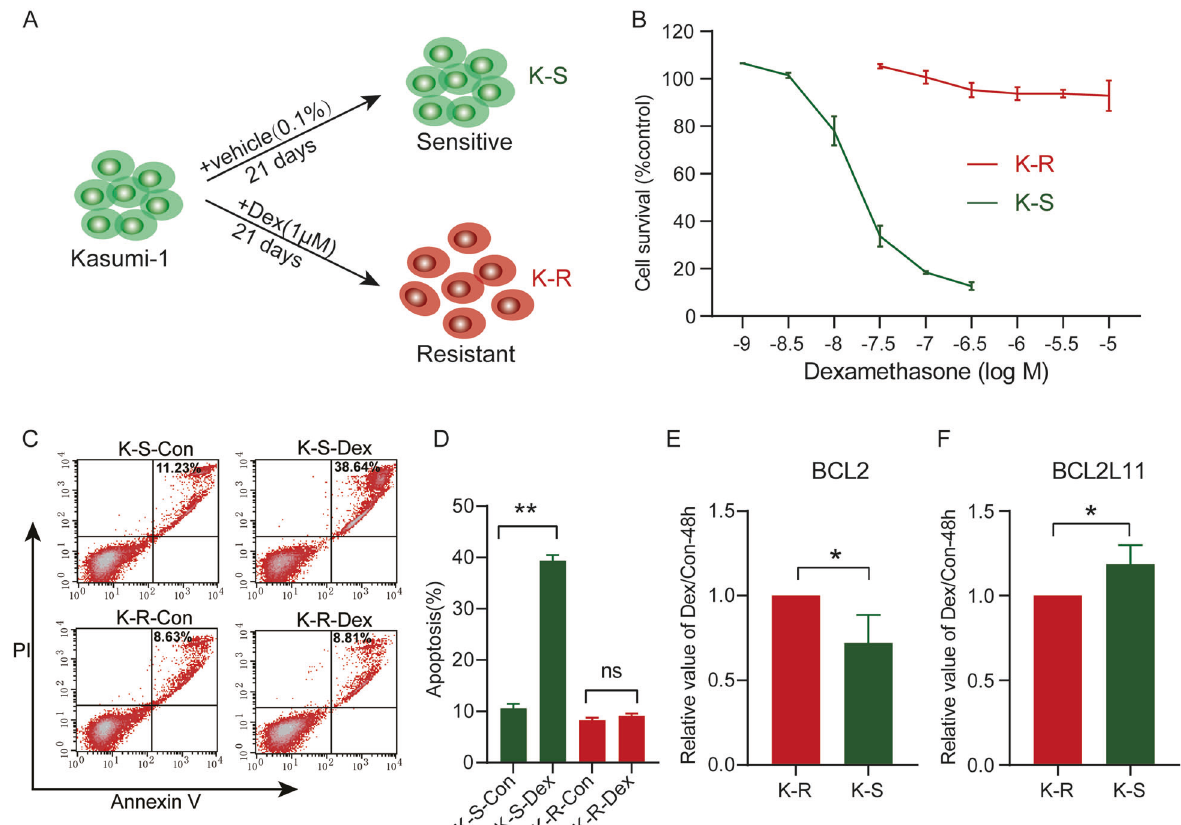
Fig. 1 Establishment and characterization of GC-resistant Kasumi-1 cells (K-R). A Schematic diagram of the experimental approach for the establishment of glucocorticoid-resistant cells in vitro. In continued presence of 1 µM dexamethasone, the residual survival colonies of Kasumi-1 were isolated and iteratively passaged over 21 days. These colonies were designated as K-R. At the same time, the same operation was performed in the control group treated with the same concentration of vehicle, named K-S. B K-R and K-S cells were treated with various concentrations of dexamethasone for 4 days, and the cell viability was measured by MTS assay. C Flow cytometry analysis of Annexin V and PI in K-R and K-S cells. Both cells were treated with vehicle and 10 µM dexamethasone for 48 h prior to staining. D Quantitative analysis of Annexin V + /PI + in fl ow cytometry. E Expression ratio of BCL2 in glucocorticoid group and control group after 48 h Dex treatment. F Expression ratio of BCL2L11 in glucocorticoid group and control group after 48 h Dex treatment. Data information: Data were represented as mean ± SD, n = 3 ( B, D – F ). Difference between groups was assessed using Student ’ s t -test: * p < 0.05, ** p < 0.01, *** p < 0.001, ns means no statistical signi fi